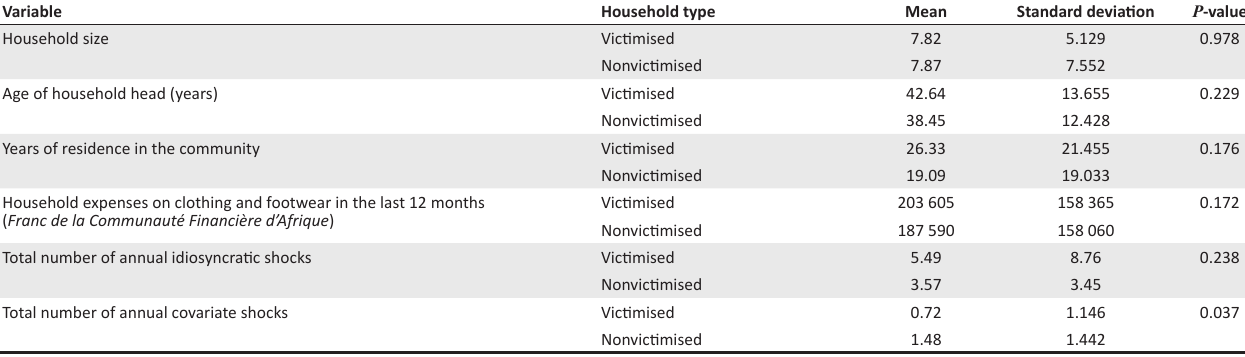
TABLE 1: Comparative socioeconomic analysis of floods – affected and nonaffected households.